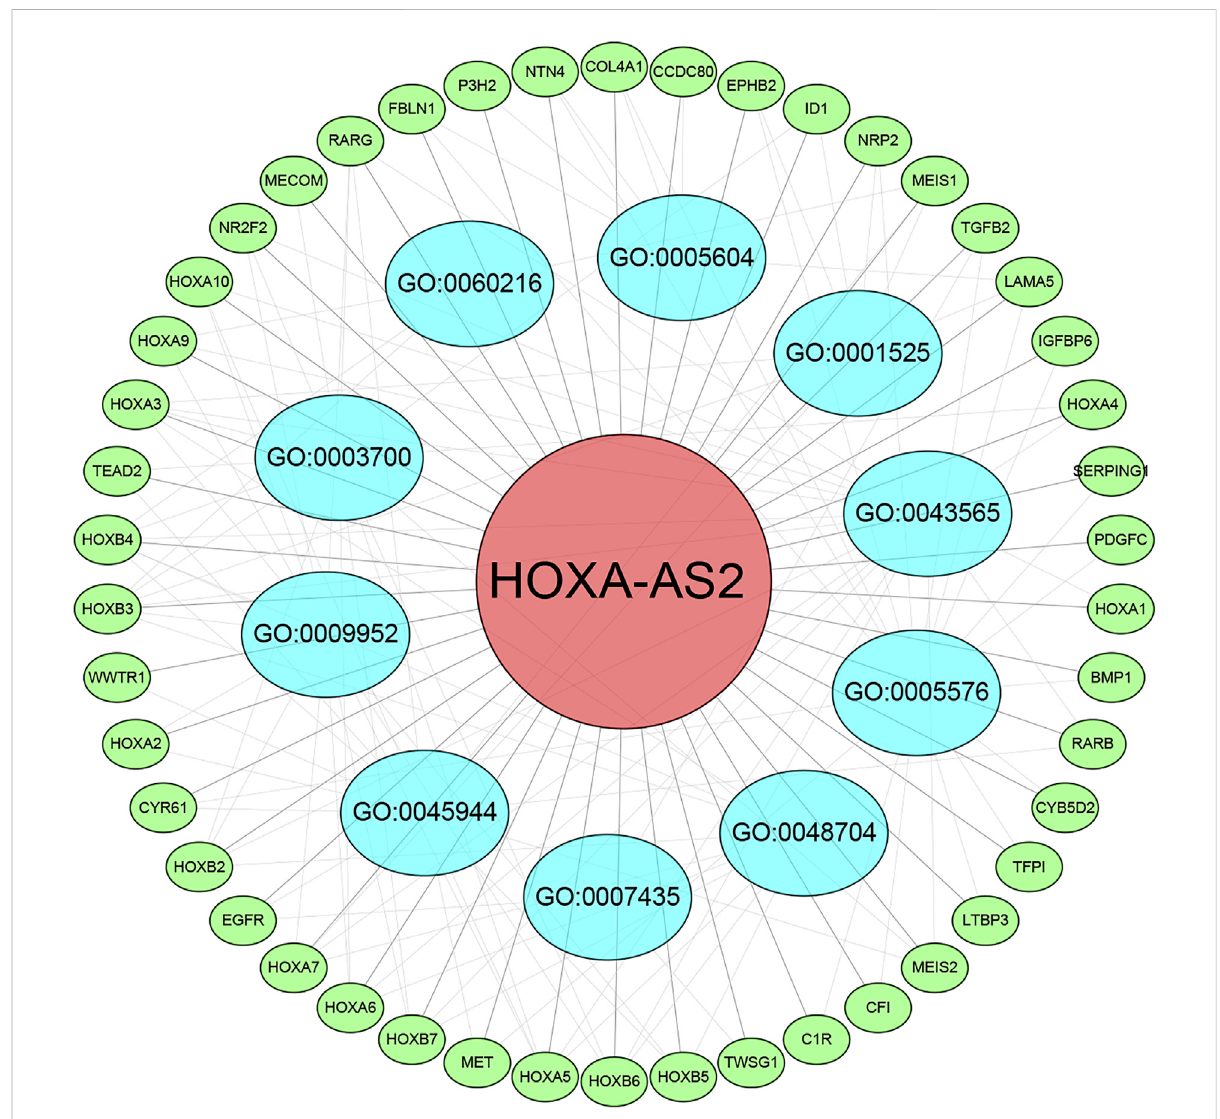
FIGURE 10 Differentially expressed gene interaction network analysis. Green nodes represent target genes and sky blue nodes represent the related pathway. As indicated in red, HOXA-AS2 localized at the center of the network.